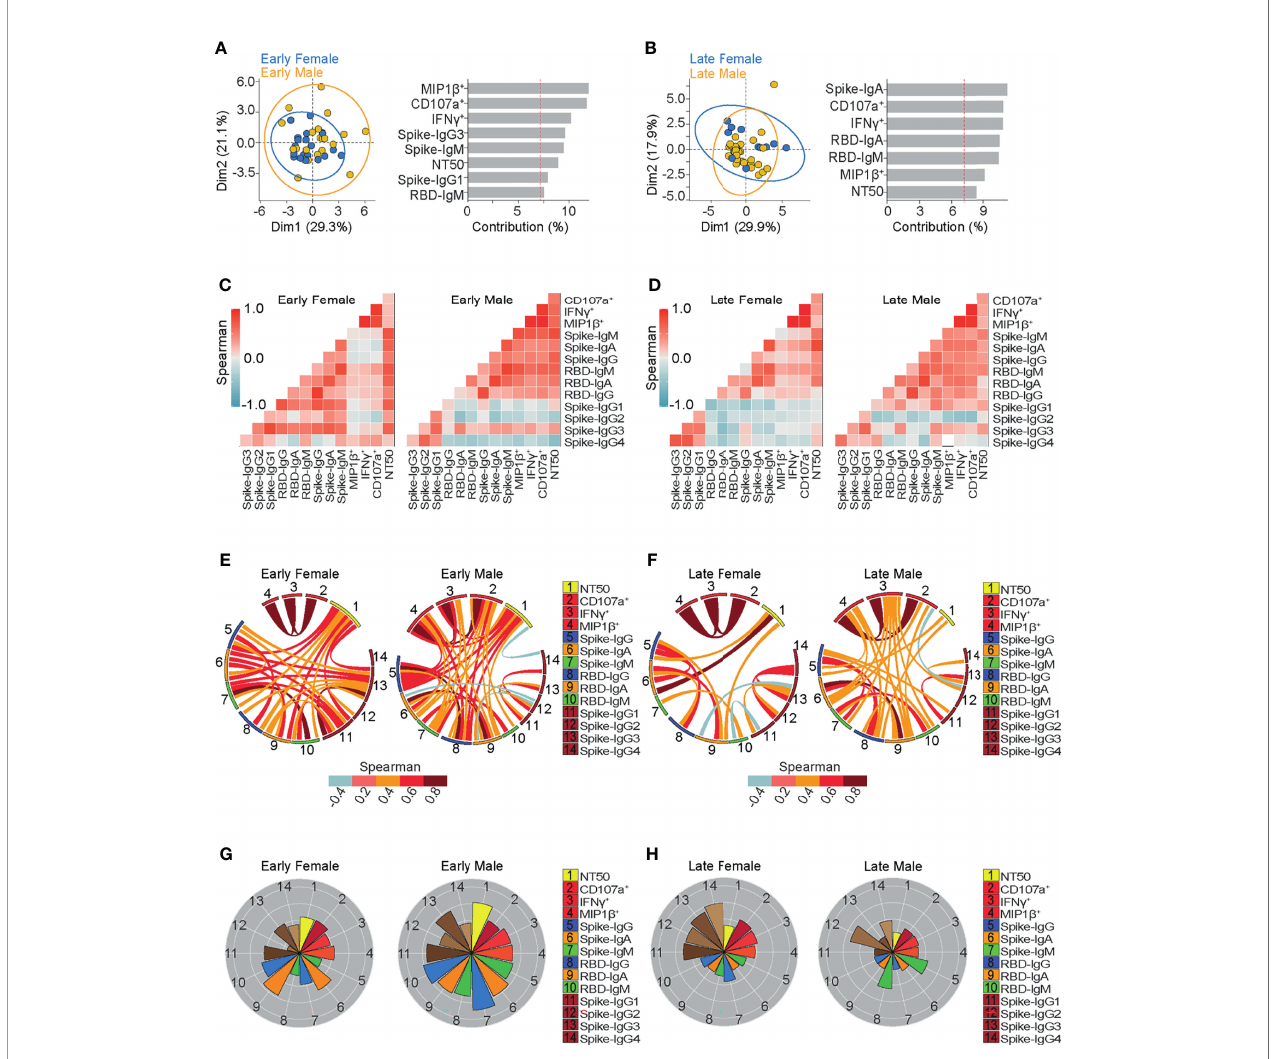
FIGURE 5 | Ab-dependent NK effector functions but not neutralization, are better sustained in females compared to males up to 6 months from the onset of symptoms. (A, B) Biplot showing the principal component analysis (PCA) depicting the early-female (20 samples from 19 donors) and early-male (22 samples from 21 donors) sub-groups of COVID-19 outpatients (A) ; the late-female (12 samples from 10 donors) and late-male (29 samples from 21 donors) sub-groups of COVID- 19 outpatients (B) . The bar graphs show the contribution of variables for both dimensions (1 and 2) in the PCA analyses. (C, D) Correlation heatmap shows the Spearman ’ s r values between the complete set of variables analyzed for early-female (20 samples from 19 donors) and early-male severe (22 samples from 21 donors) sub-groups of outpatients (C) ; or for late-female (12 samples from 10 donors) and late-male (29 samples from 21 donors) sub-groups of outpatients (D) . A scale of blue-to-red color indicates a negative-to-positive correlation. (E, F) Circos plot shows signi fi cant Spearman correlations without adjustment between the pairs of variables displayed in (C) or (D) for early-female and early-male sub-groups of outpatients (E) ; or for late-female and late-male sub-groups of outpatients (F) . The color of the links represents the magnitude of Spearman ’ s r values. (G, H) Polar plots showing the differential composition of humoral immune responses at different sub-groups. Each bar represents the mean z-scores of variables for early-female (20 samples from 19 donors) or early-male outpatients (22 samples from 21 donors) (G) ; and late-female (12 samples from 10 donors) or late-male outpatients (29 samples from 21 donors) (H)